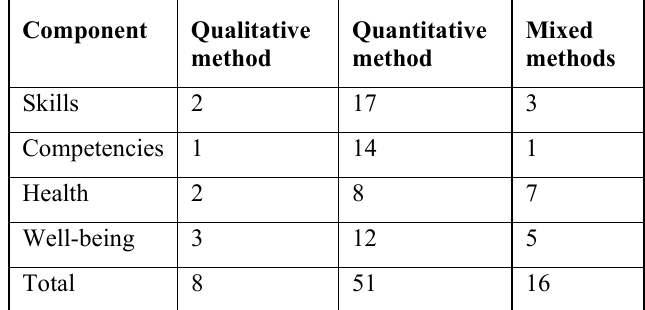
Table 7. Research components and methodology